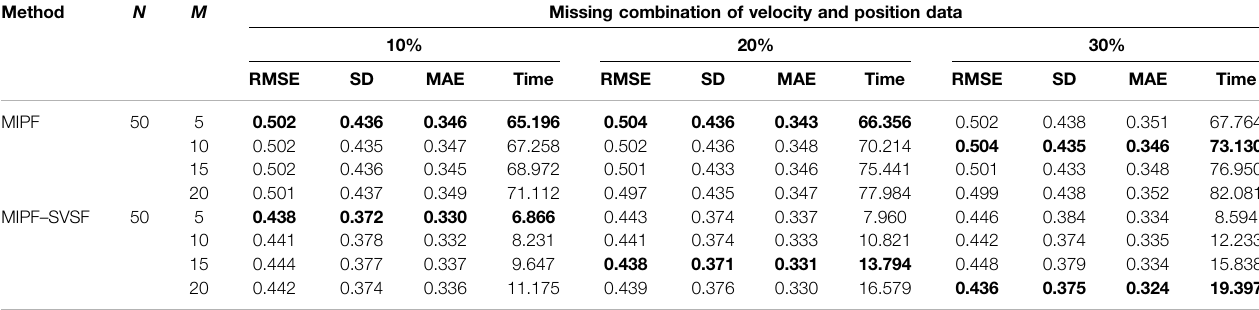
TABLE 3 | The performance of the MIPF and MIPF-SVSF during missing combination of position and velocity data. Method